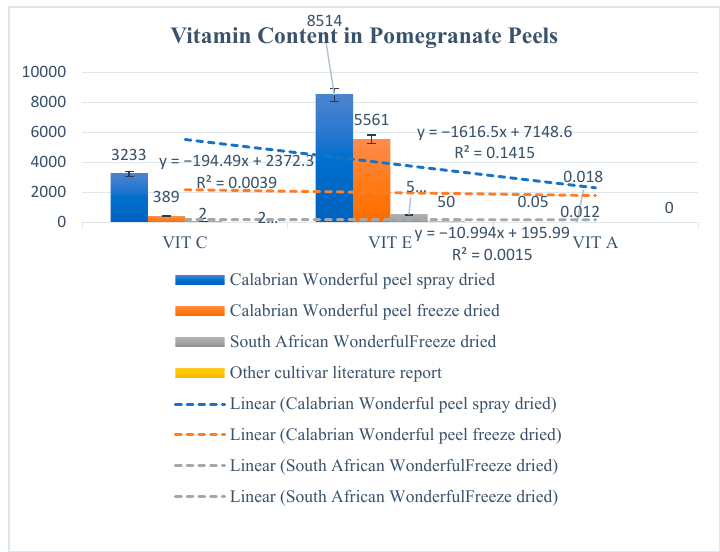
Figure 2. Vitamin A (µg retinol g -1 DW), C (µg ascorbate g -1 DW), and E (µg α -tocopherol g -1 DW) in peels of different pomegranate cultivars dried differently. PSD (spray-dried Wonderful peel, experimental data); CFD (Calabrian Wonderful peel freeze-dried, experimental data); SAFD (South African Wonderful peel freeze-dried, literature data); IC (Indian cultivar peel freeze-dried, literature data). The experimental data are the mean of six replicates.